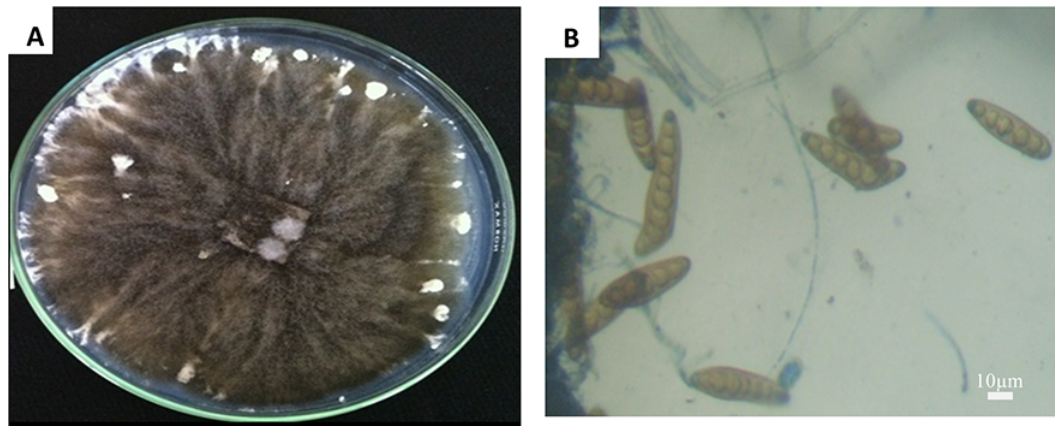
Figure 1 ( A ) Seven-day-old pure culture of Bipolaris oryzae isolate on rice flour-based medium. ( B ) Conidia of B. oryzae (×400).